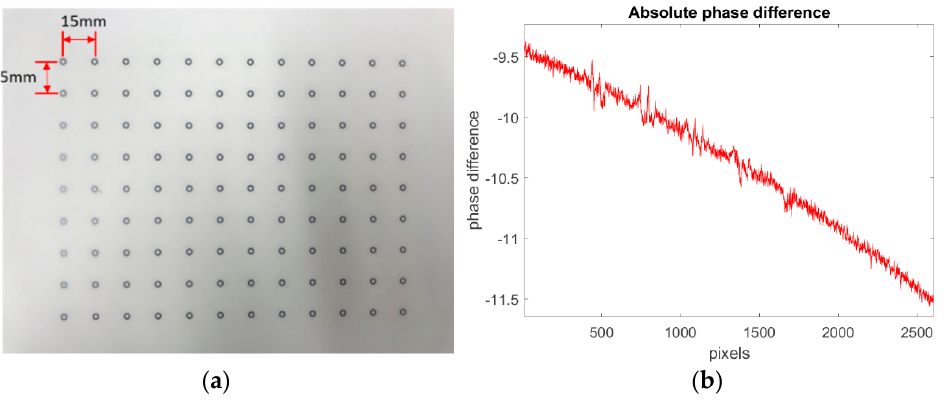
Figure 2. Calibration board with ring marks: ( a ) photograph of the calibration board with concentric rings (tolerance range of the centre positions within ±0.002 mm); and ( b ) phase errors from the ring marks.